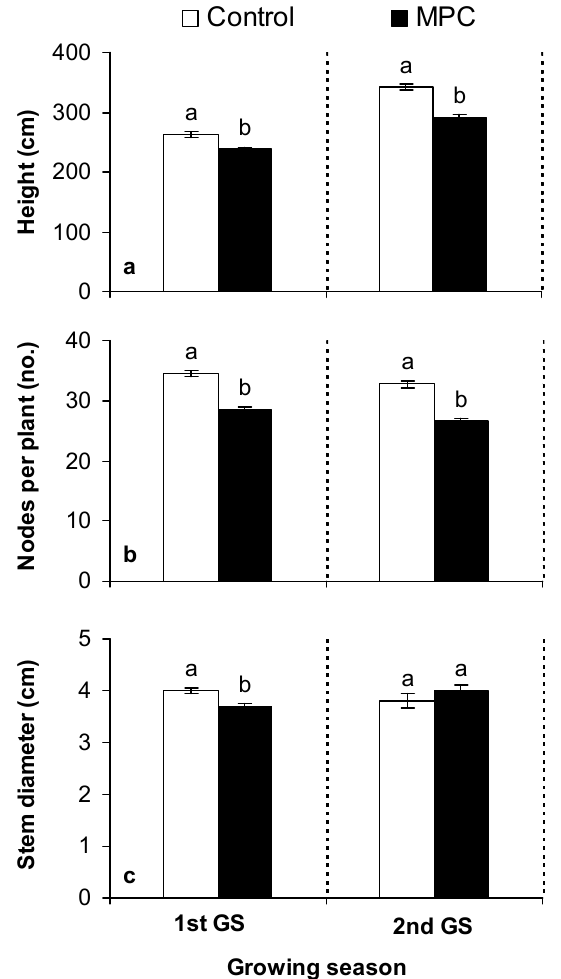
Figure 2. Plant height ( a ), number of nodes ( b ), and stem diameter ( c ) of sunflower plants at maturity as influenced by foliar applications of MPC (37.5 + 37.5 g ha − 1 in the 1st growing season (GS) and 37.5 + 37.5 g + 37.5 g ha − 1 in the 2nd GS). Different letters within each GS show statistically significant differences at p < 0.05 and vertical bars denote standard errors of means ( n = 40). MPC, mepiquat chloride.